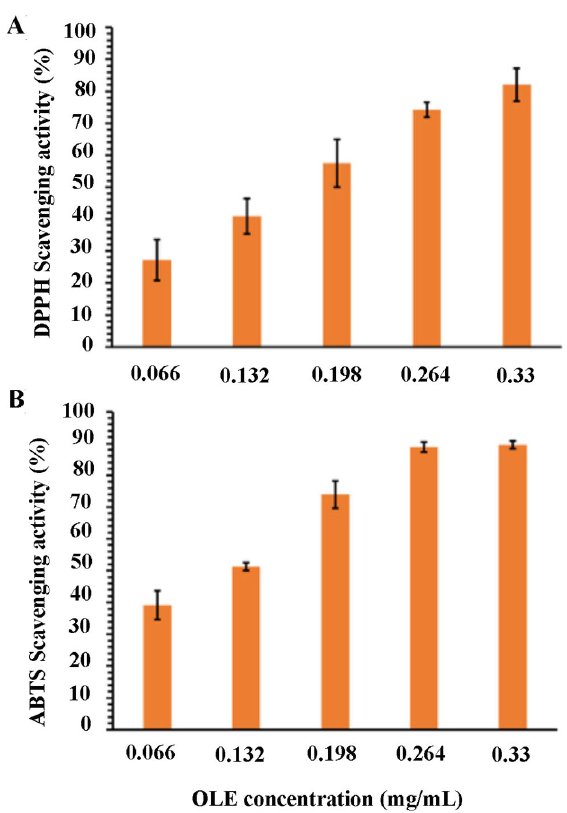
Figure 1. Antioxidant activity of OLE against DPPH • ( A ) and ABTS • ( B ) expressed as percentage of radical scavenging activity versus extract concentration. The results represent the mean ± SD of three independent experiments.